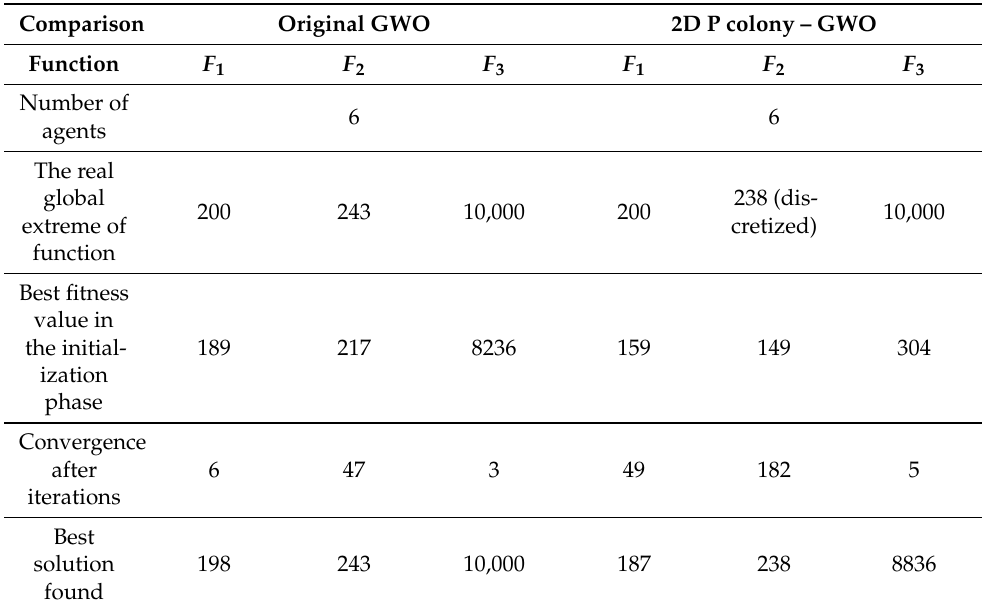
Table 7. Summary of